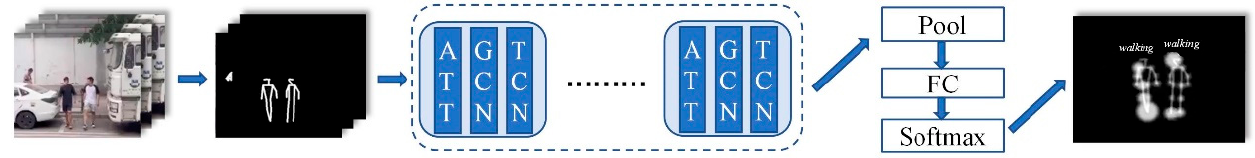
Figure 5. Schematic diagram of pedestrian action classification.